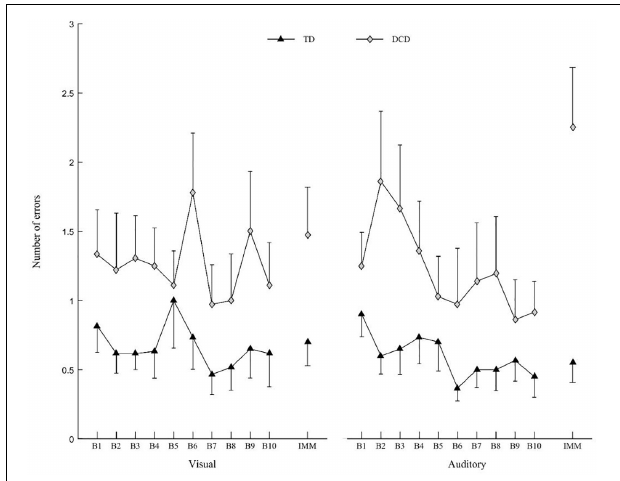
FIGURE 5 | Mean number of errors for DCD group (gray diamonds) and TD group (black triangles) for visual (left) and auditory modality (right). Vertical bars represent inter-individual variability (standard